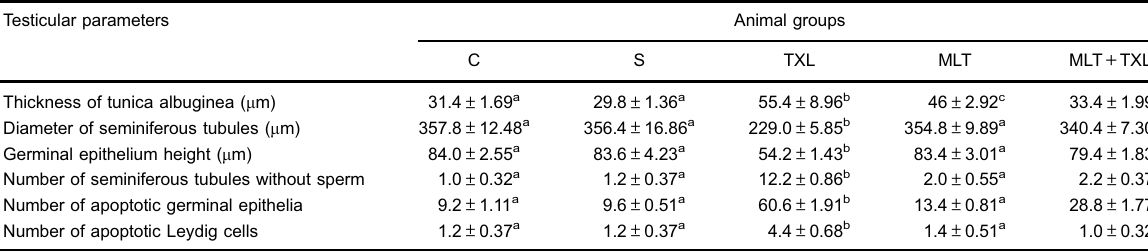
Table 2. Histomorphometrical analysis of testicular parameters of control and experimental animal groups. Testicular